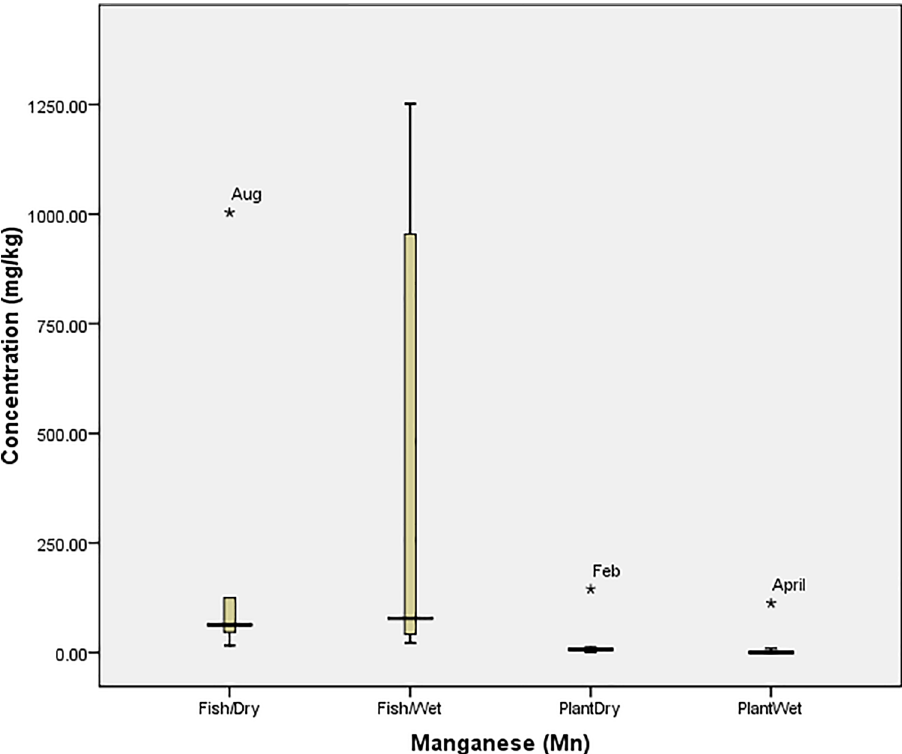
Figure 6. Tolerability of Manganese (Mn) in O. niloticus (Fish) and I. aquatica (Plant) in Wet and Dry Seasons (Source: Field Survey).